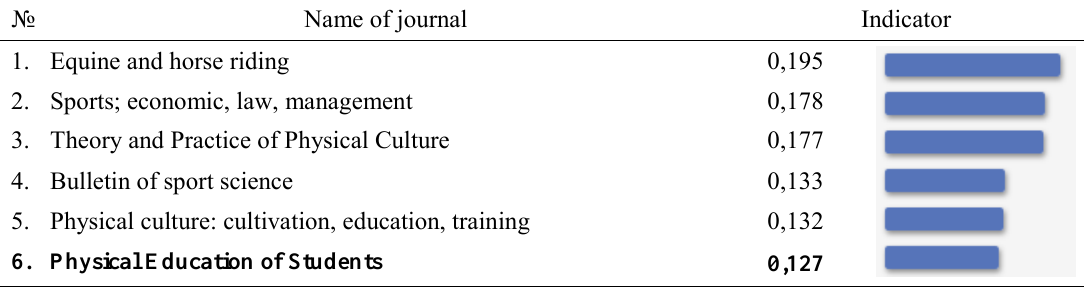
Table 1. Rating of journals in RISC data base (Physical culture and sports; 64 journals in total) for 2014 by indicator SCIENCE INDEX (http://elibrary.ru)